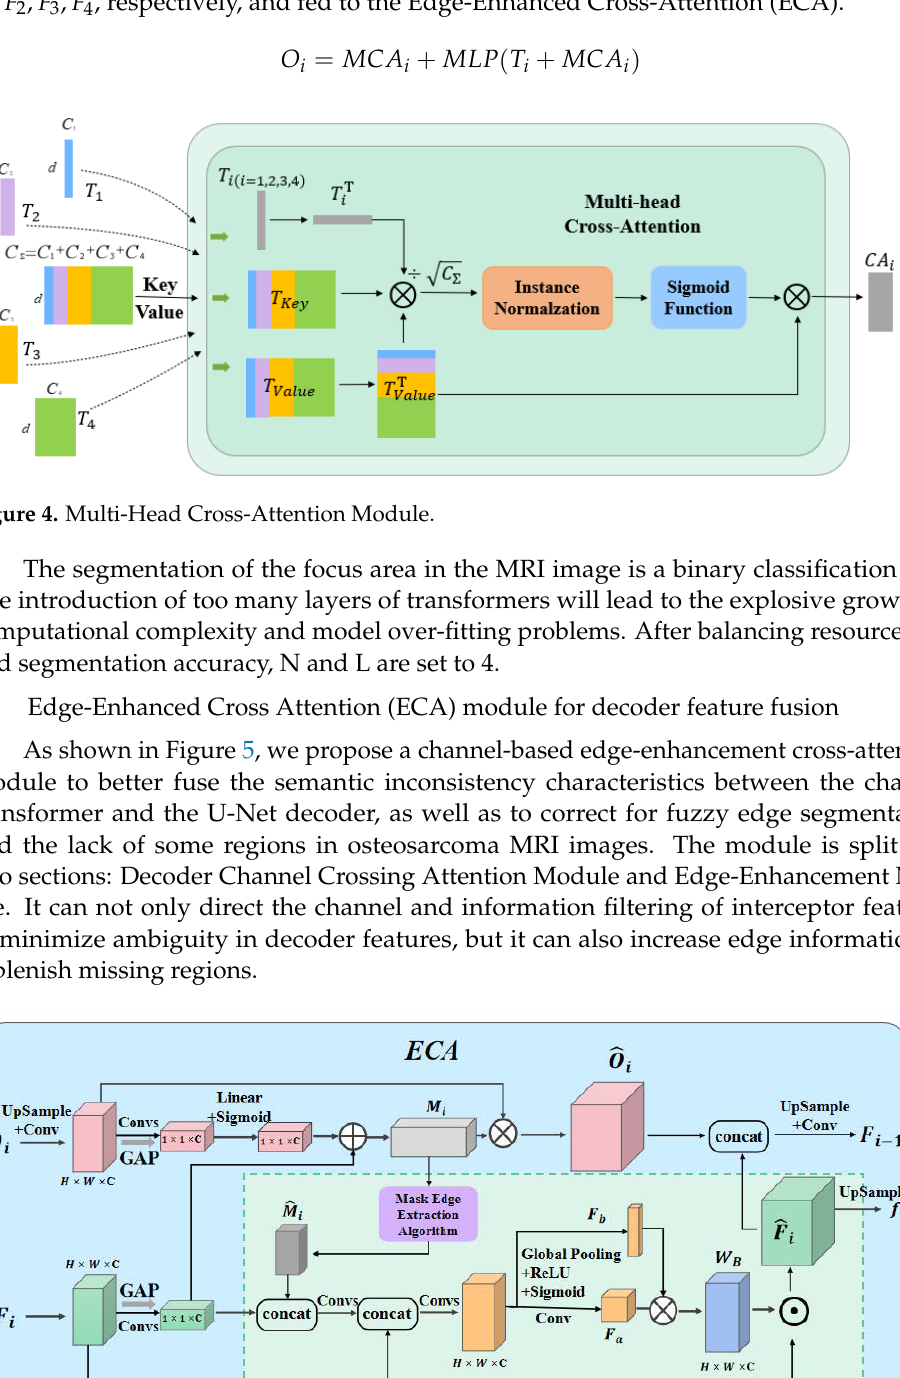
Figure 4. Multi-Head Cross-Attention Module.